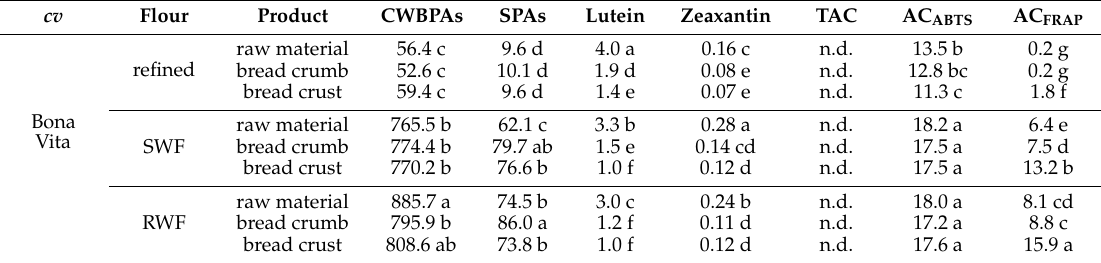
Table 4. Cell wall-bound phenolic acids (CWBPAs), soluble phenolic acids (SPAs), antioxidant capacity (AC), xanthophylls (lutein and zeaxanthin) and total anthocyanin content (TAC) in raw material (flour), bread crust and bread crumb obtained from refined white flour, stone (SWF) and roller-milled (RWF) whole-grain flour of Bona Vita and Skorpion cvs